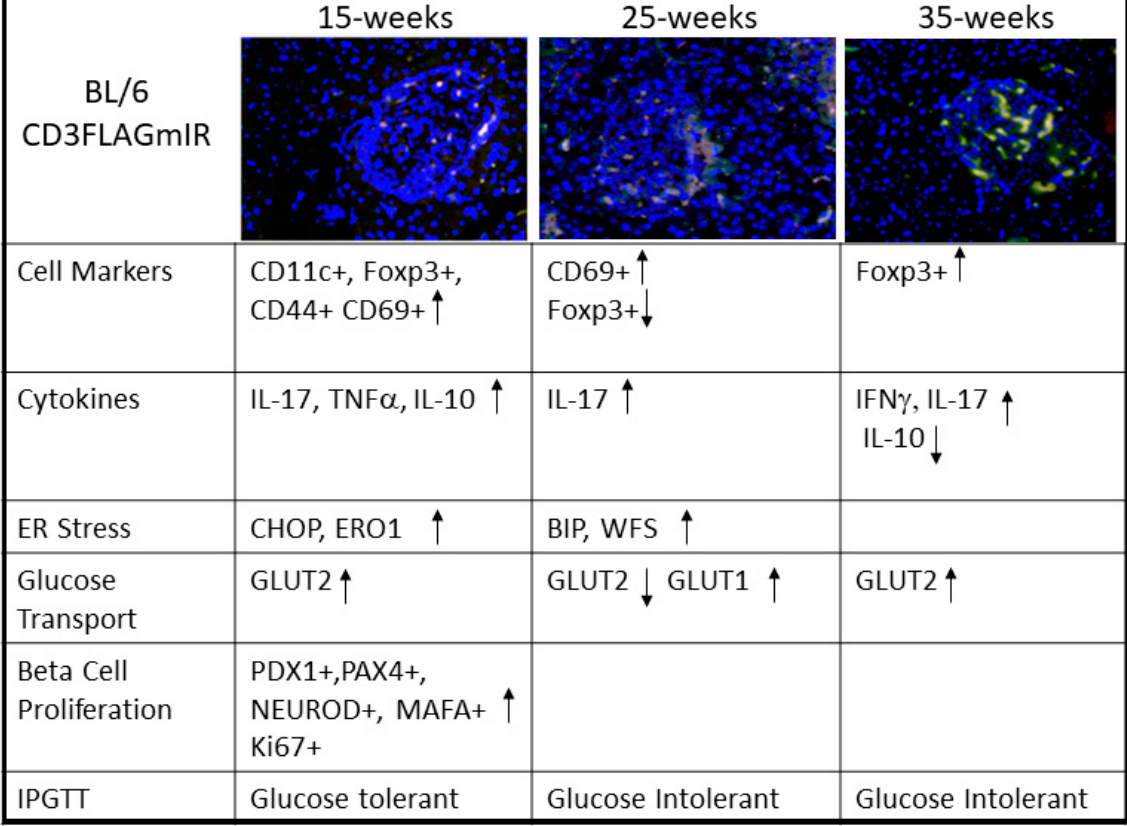
Figure 14. Summary of manuscript findings, demonstrating the effects of CD3FLAGmIR T cells on cell markers, cytokines, ER stress, glucose transport, beta cell proliferation, and glucose tolerance over time.